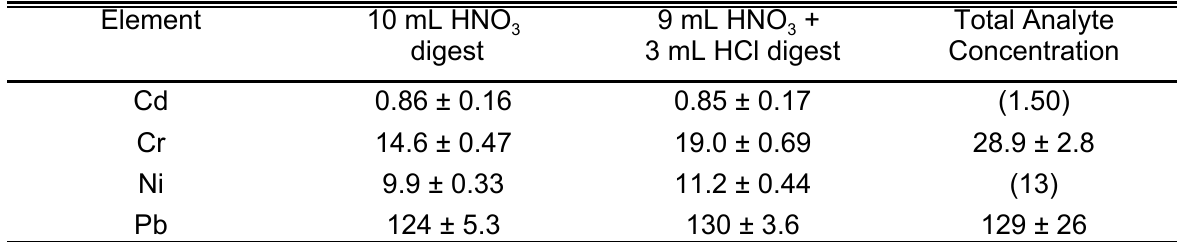
COMPARISON OF ANALYTE RECOVERIES FROM SRM 4355 (PERUVIAN